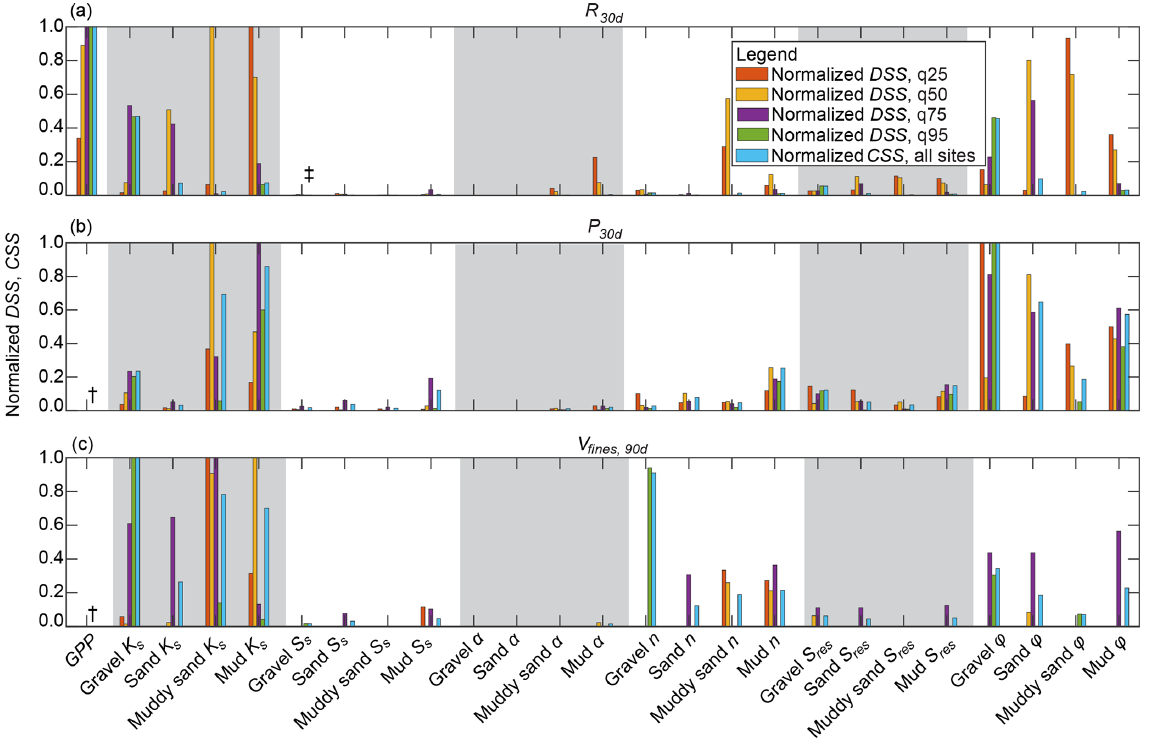
Figure 10. Normalized dimensionless scaled sensitivities (DSS) evaluated for each model parameter and model outputs (a) R 30d , (b) P 30d , and (c) V fines , 90d at sites q25, q50, q75, and q95 and normalized composite scaled sensitivities (CSS) evaluated for each parameter and model output at all sites. DSS and CSS of parameters were scaled to the range [0, 1] (i.e., normalized). † DSS and CSS of GPP were not evaluated for P 30d and V fines , 30d . ‡ DSS and CSS values below 0.01 are not shown.